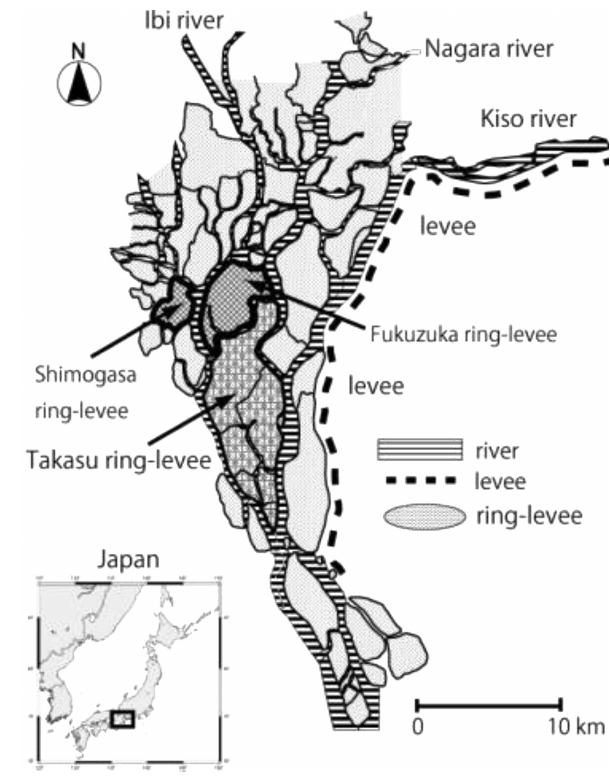
Figure 1. Ring levees around 1870 (based on a map in Nanno town, 1978).